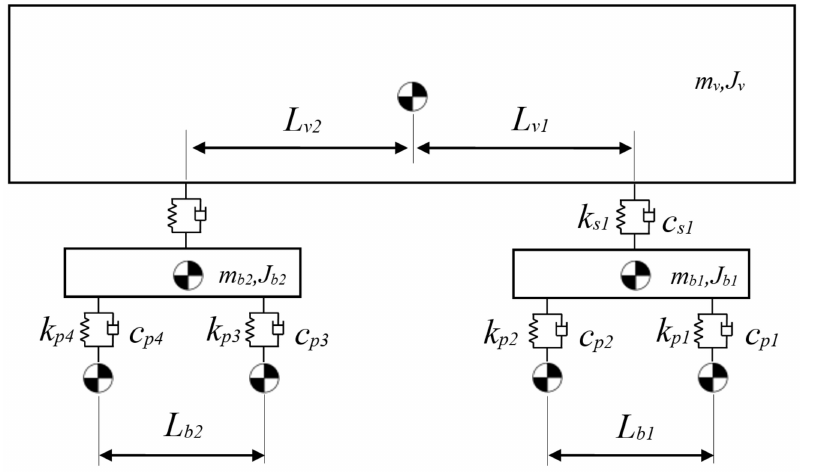
Figure 4. Train model.